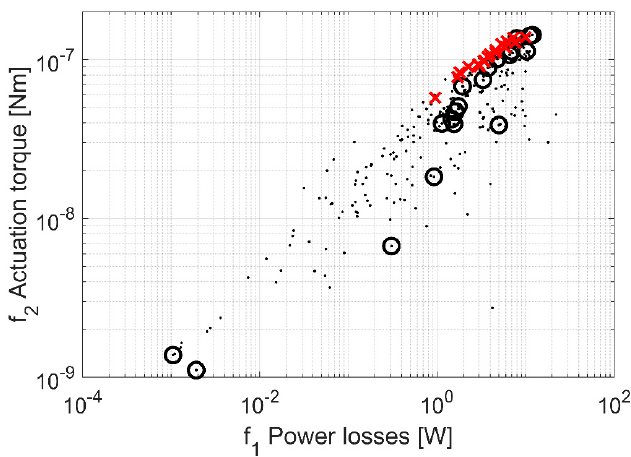
Figure 7. f 1 –f 2 projection of the objective space: dot—individuals, cross—NSGA-III solutions, circle—MP-NSGA solutions.